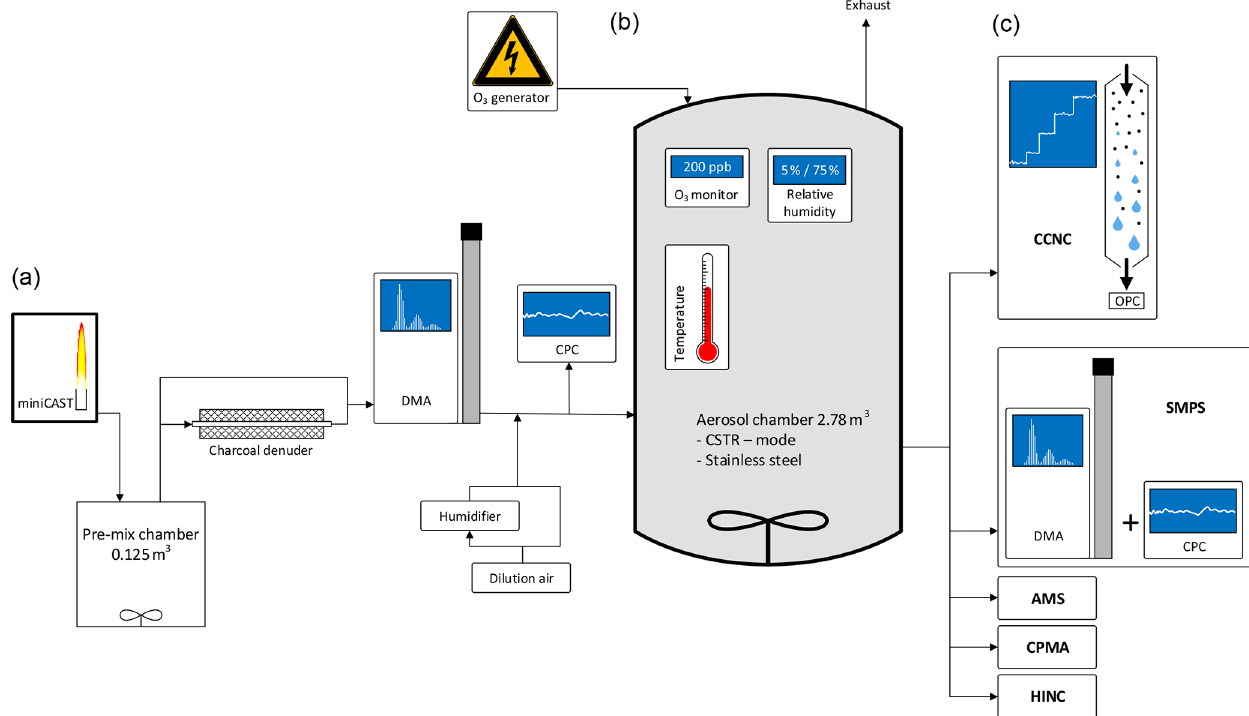
Figure 1. Schematic of the experimental setup. Indicated are aerosol production and conditioning (a) , the aging chamber (b) , and the characterization instruments (c)